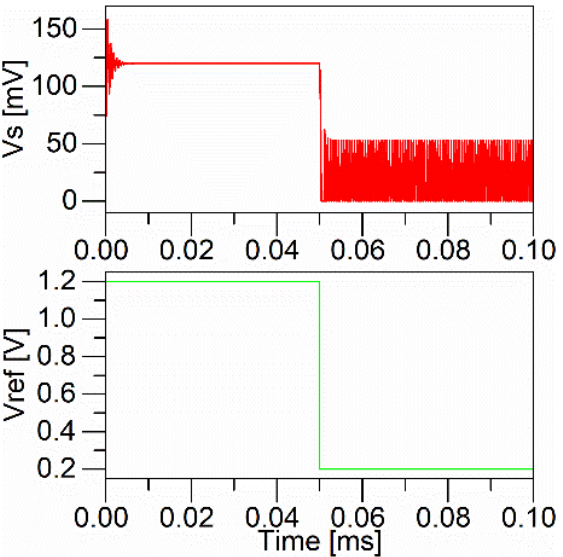
Figure 11. Transient response of the current source (capacitor C5 was removed).